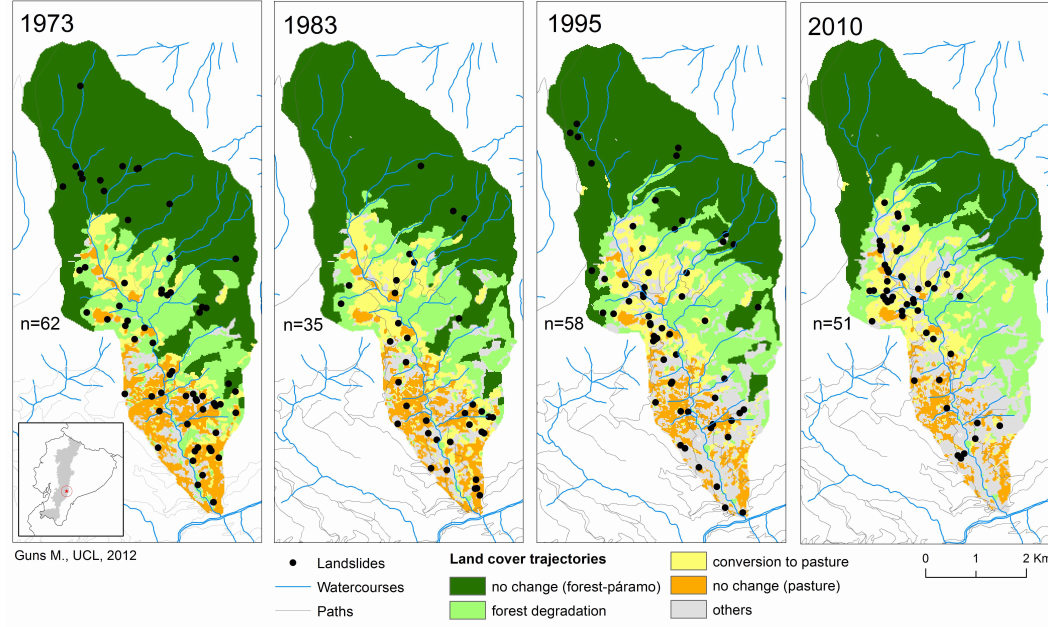
Fig. 1. Time series (1973–2010) of landslide occurrence and land cover in the Llavircay catchment (southern Ecuadorian